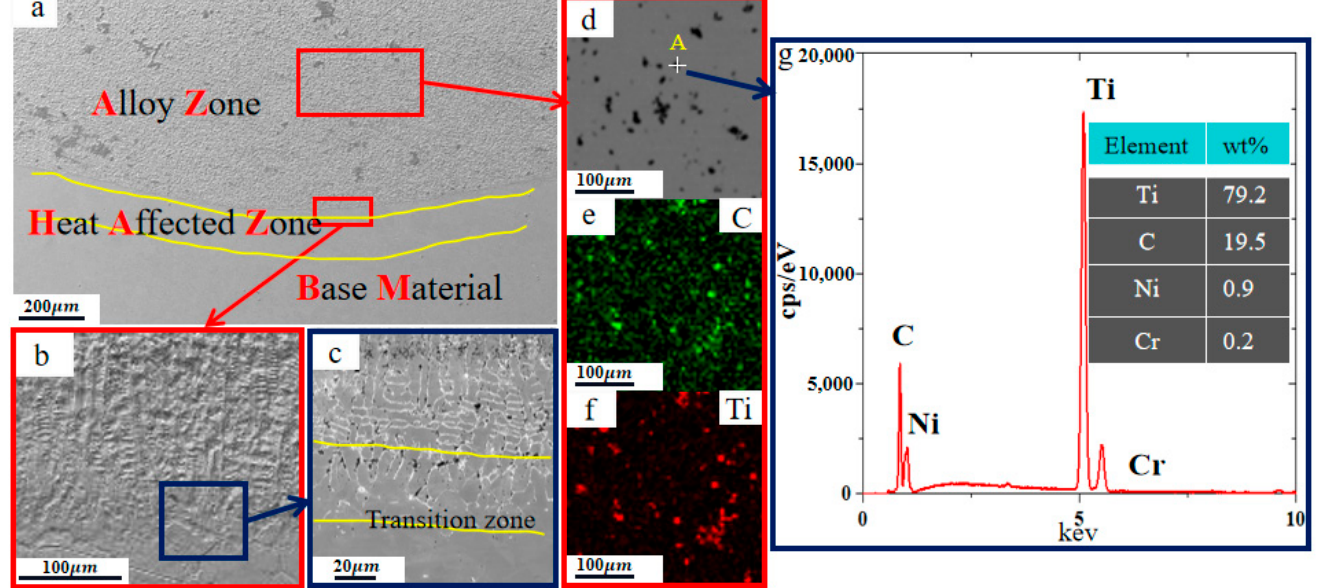
Figure 2. SEM morphology and EDS results of a cross-section of the alloy zone at C80: ( a ) SEM image; ( b , c ) Locally enlarged SEM image; ( d ) the backscatter image; ( e , f ) Results of EDS polygon scans; ( g ) A spot EDS point scan results.